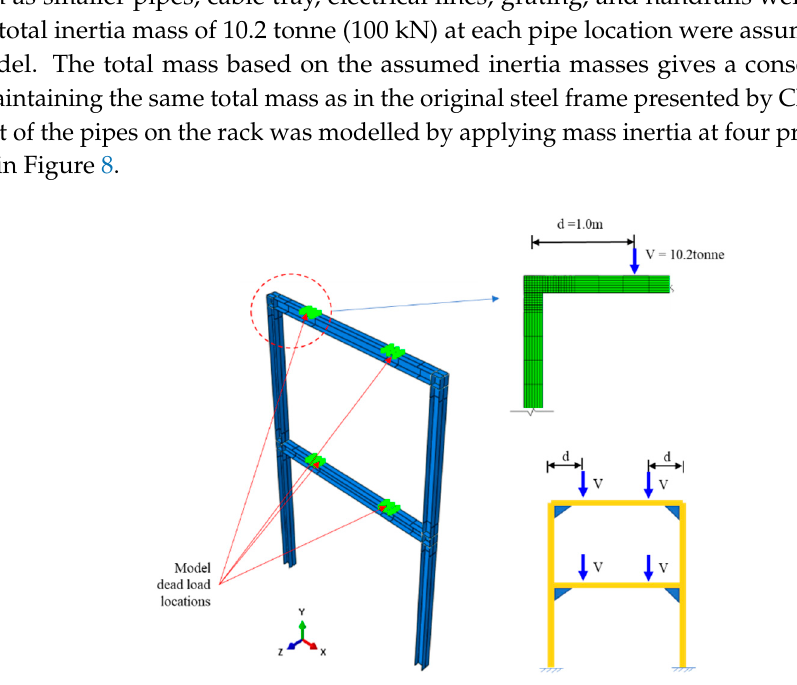
Figure 8. Pipe inertia masses and locations.